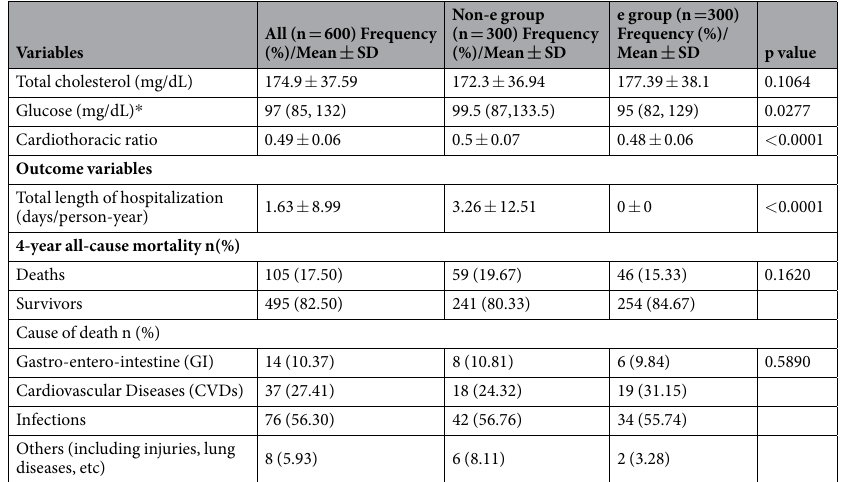
Table 1. Demographic factors and clinical characteristics of the study patients. e group: e-intervention group; non-e group: non-e-intervention group; HD: hemodialysis; CGN: chronic glomerulonephritis; HBV: hepatitis B virus; HCV: hepatitis C virus; A-V: arteriovenous; nPCR: normalized protein catabolic rate; TACurea: time- averaged concentration of urea; URR: urea reduction ratio; EPO: erythropoietin; iPTH: intact parathyroid hormone. ^ Double lumen catheter includes tunneled cuffed catheter * The variables with skew distribution were presented as median (1st-quartile, 3rd-quartile) and tested with Mann-Whitney U-test